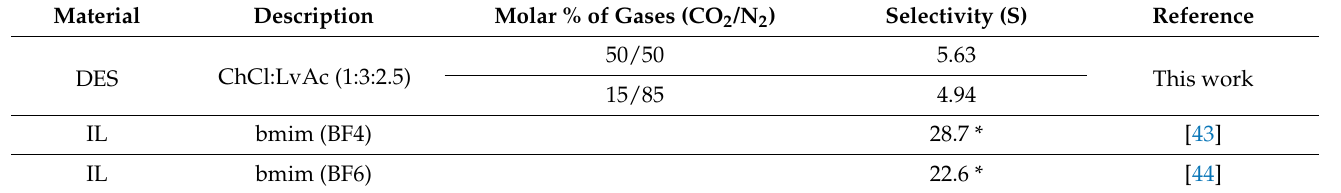
Table 3. Selectivity of some absorbents at 100 kPa and 25 ◦